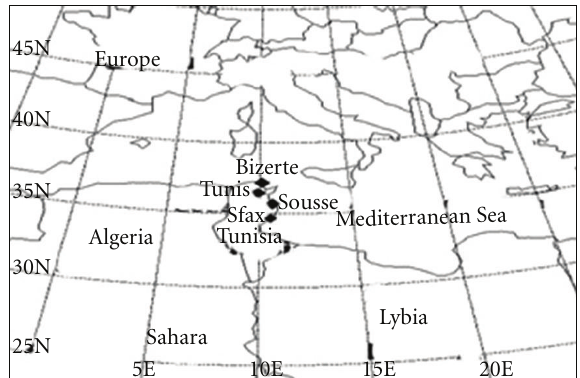
Figure 1: North African map displaying Tunisia, the measurement sites locations Sfax (34 ◦ 44 (cid:3) N, 10 ◦ 46 (cid:3) E), Bizerte (37 ◦ 16 (cid:3) N, 9 ◦ 52 (cid:3) E), Sousse (35 ◦ 49 (cid:3) N, 10 ◦ 38 (cid:3) ), Tunis (36 ◦ 49 (cid:3) N, 10 ◦ 11 (cid:3) E), and the African